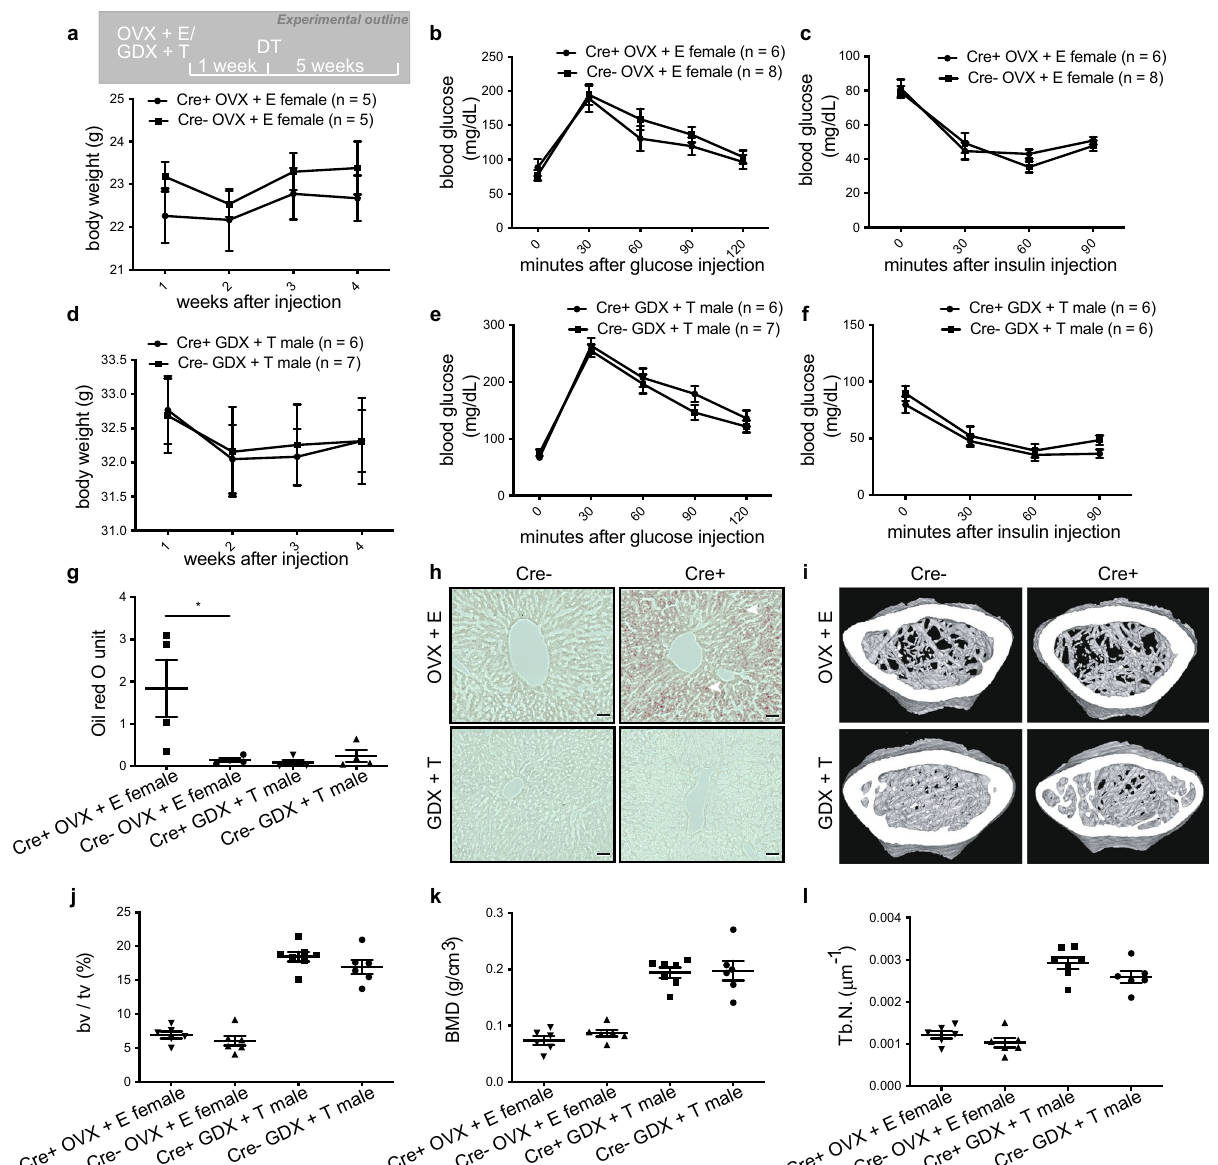
Fig. 3 | Sex-steroid replacement abolishes metabolic disorders but does not improve hepatic steatosis in gonadotrope-ablated female mice. a , d Body weight ( a , d ), glucose tolerance ( b , e ), insulin tolerance ( c , f ), and liver oil red O staining quanti fi cation ( g ) and representative images ( h ; scale bars=50 μ m, fi lled arrowheads indicate lipid droplets.) in gonadotrope-ablated (Cre+) and control (Cre − ) ovariectomized (OVX) female and gonadectomized (GDX) male mice with estradiol (E) or testosterone (T) replacement, respectively. Representative μ CT